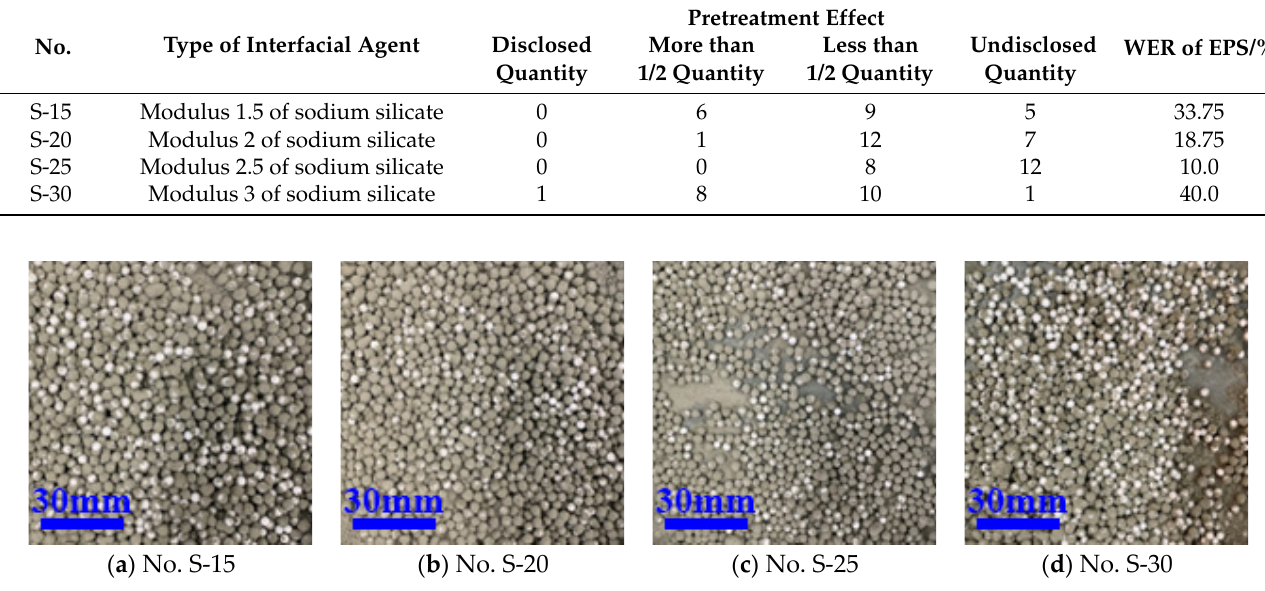
Figure 2. The exposure of CSLA after sodium silicate treatment.